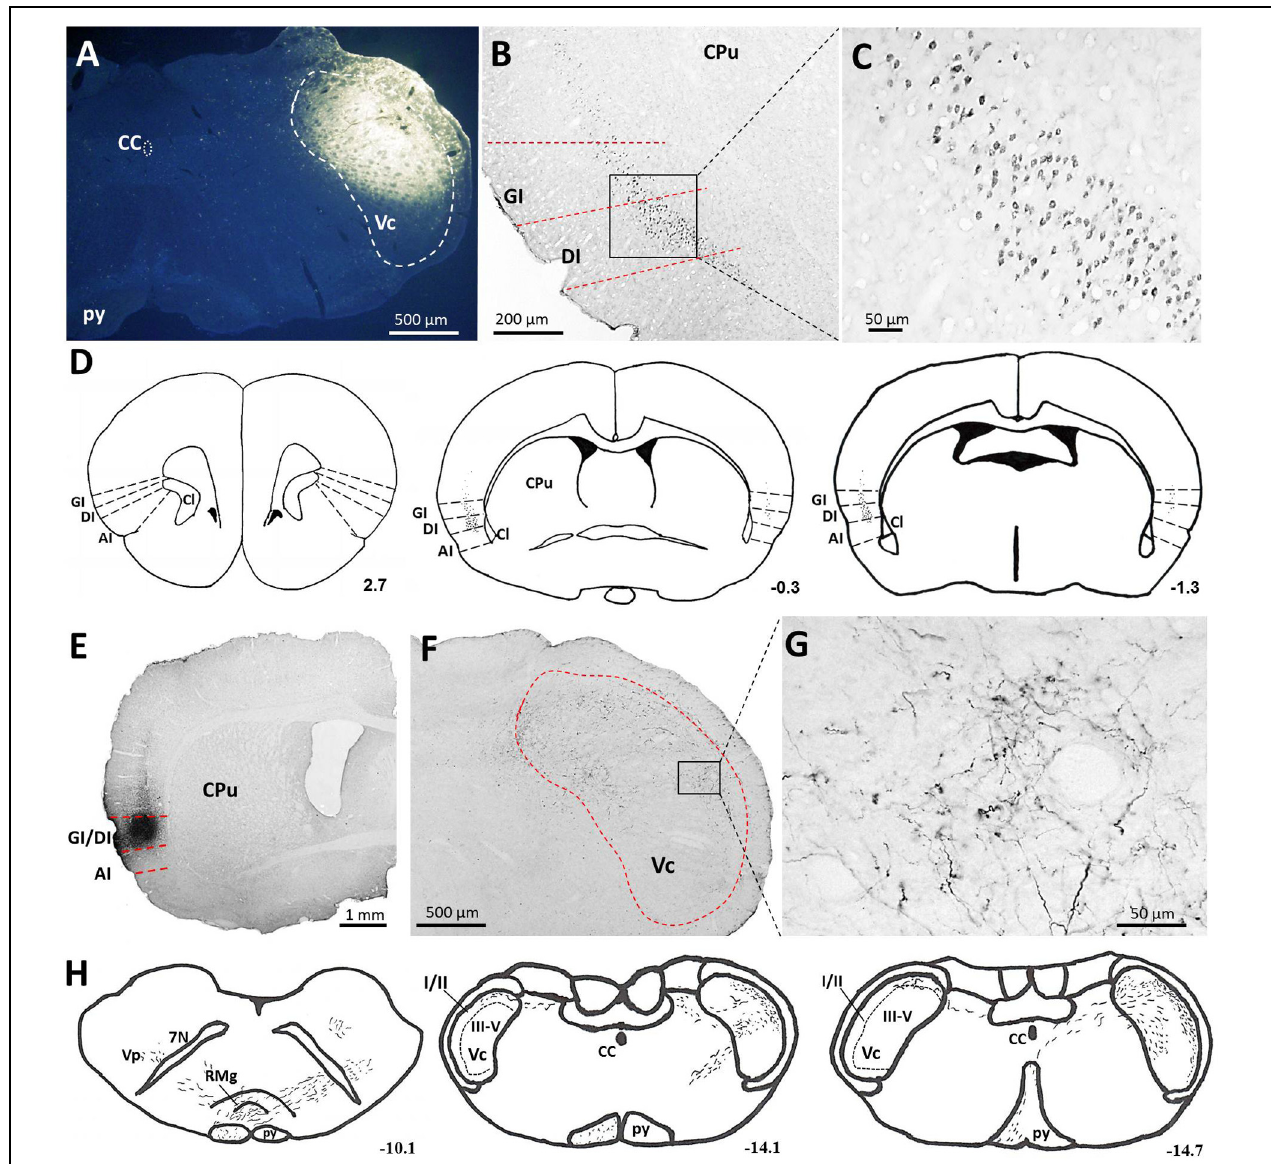
FIGURE 2 | Projections from the IC to the Vc. (A–D) Photomicrographs showing FG injection sites in the Vc (A) of the brainstem and the resultant FG-labeled neurons in the IC (B,C) . (B) The retrogradely FG-labeled neurons were mainly distributed in the layer V of the GI and DI of the contralateral IC. (C) The rectangular area in (B) was enlarged and displayed in (C) . (D) Drawings of the distribution of retrogradely FG-labeled neurons in the IC after FG injection into the unilateral Vc. Retrogradely FG-labeled neurons, indicated by dots, were predominantly observed on the contralateral (left) side to the FG injection site. (E–G) Photomicrographs showing PHA-L injection sites (E) and the resultant PHA-L-labeled axonal fibers and terminals in the Vc of the brainstem (F,G) . (F) Anterogradely PHA-L-labeled axonal fibers and terminals originated from the GI/DI of the IC were observed on the contralateral side of laminae I-V of the Vc. (G) The rectangular area in (F) was enlarged and displayed in (G) . (F) Drawings of the distribution of anterogradely PHA-L-labeled axonal fibers and terminals in the Vc and other regions in the brainstem. Scale bar = 500 μ m in (A,F) , 200 μ m in (B) , 50 μ m in (C,G) , and 1 mm in (E) . The numbers (D,H) correspond to the distance in millimeters (mm) posterior to bregma in the brain. CC, central canal; py, pyramidal tract; Vc, trigeminal caudal subnucleus; IC, insular cortex; GI, granular insular cortex; DI, dysgranular insular cortex; AI, agranular insular cortex; CPu, caudate putamen; Cl, claustrum; Vp, trigeminal principal nucleus; 7N, facial nerve; RMg, raphe magnus